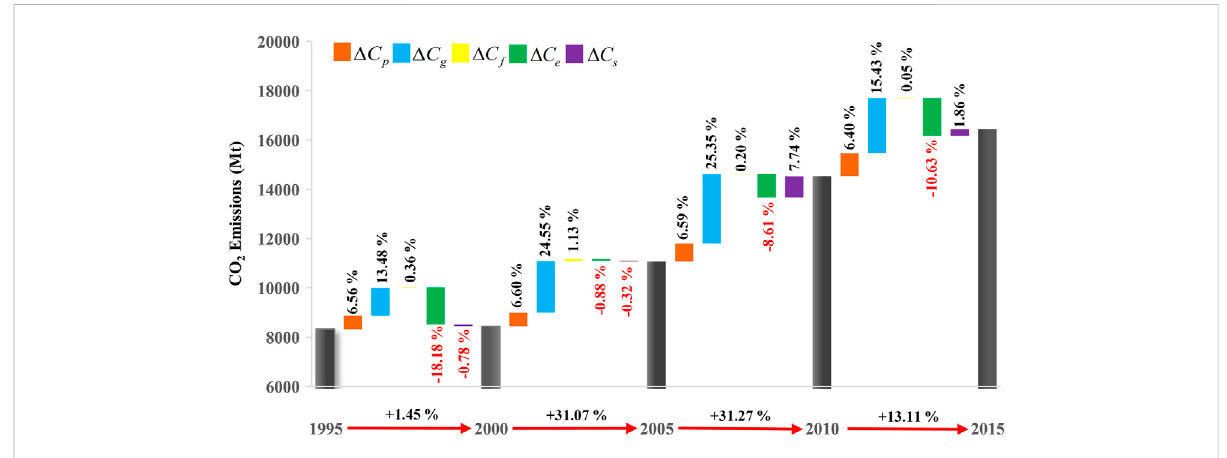
FIGURE 7 Consumption-based driving factors of carbon emission decoupling in the Belt and Road